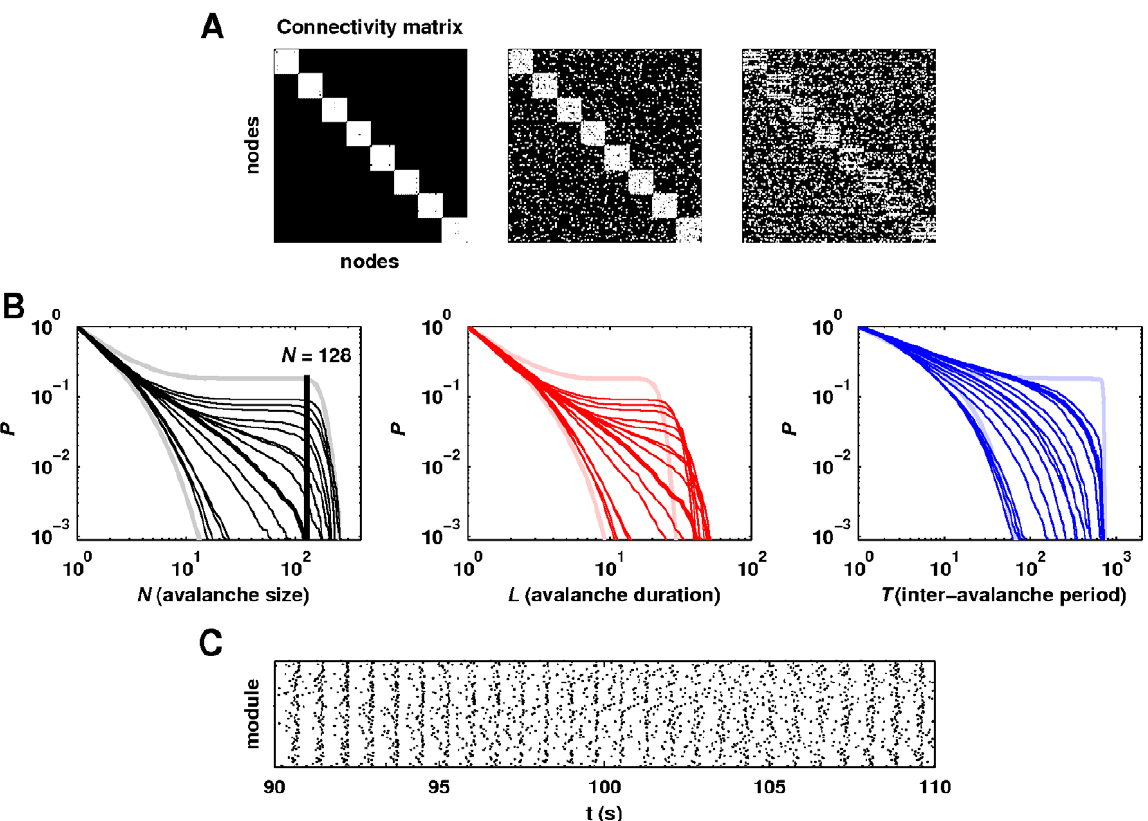
Figure 4. Phase transition from subcritical to supercritical network dynamics. (a) Illustrative ordered (left), intermediate (center) and random (right) nonhierarchical connectivity matrices. Nonhierarchical networks are characterized by a homogeneous density of between-module excitatory connections (Figure 2a, blue lines) (b) Cumulative probability distributions of avalanche sizes, avalanche durations and inter-avalanche intervals emergent on nonhierarchical networks. Subcritical dynamics (concave distributions) correspond to less randomized networks, supercritical dynamics (convex distributions) correspond to more randomized networks, while critical dynamics (linear-like distributions, in bold) occur between these two extremes. Gray, pink and light blue distributions correspond to random networks (concave distributions) and ordered networks (convex distributions). (c) An illustrative module spike raster of critical dynamics.